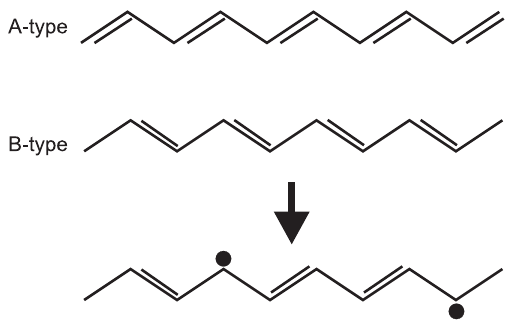
Figure 29. A- and B-type of trans -polyacetylene. The ground state is degenerated. By photon excitation, solitons and anti-solitons are created in the polymer chain which move along the chain and annihilate when they meet each